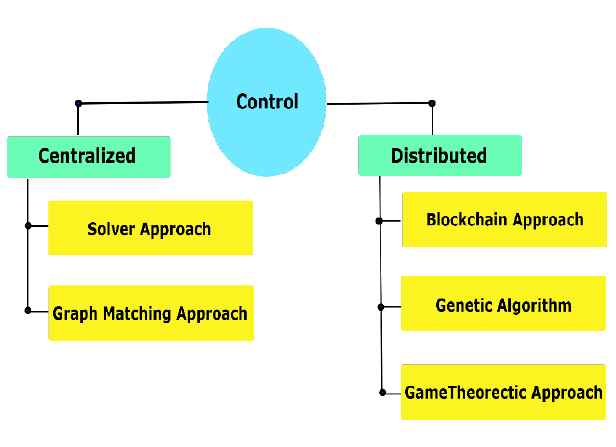
Figure 5. Resource control of edge computing model